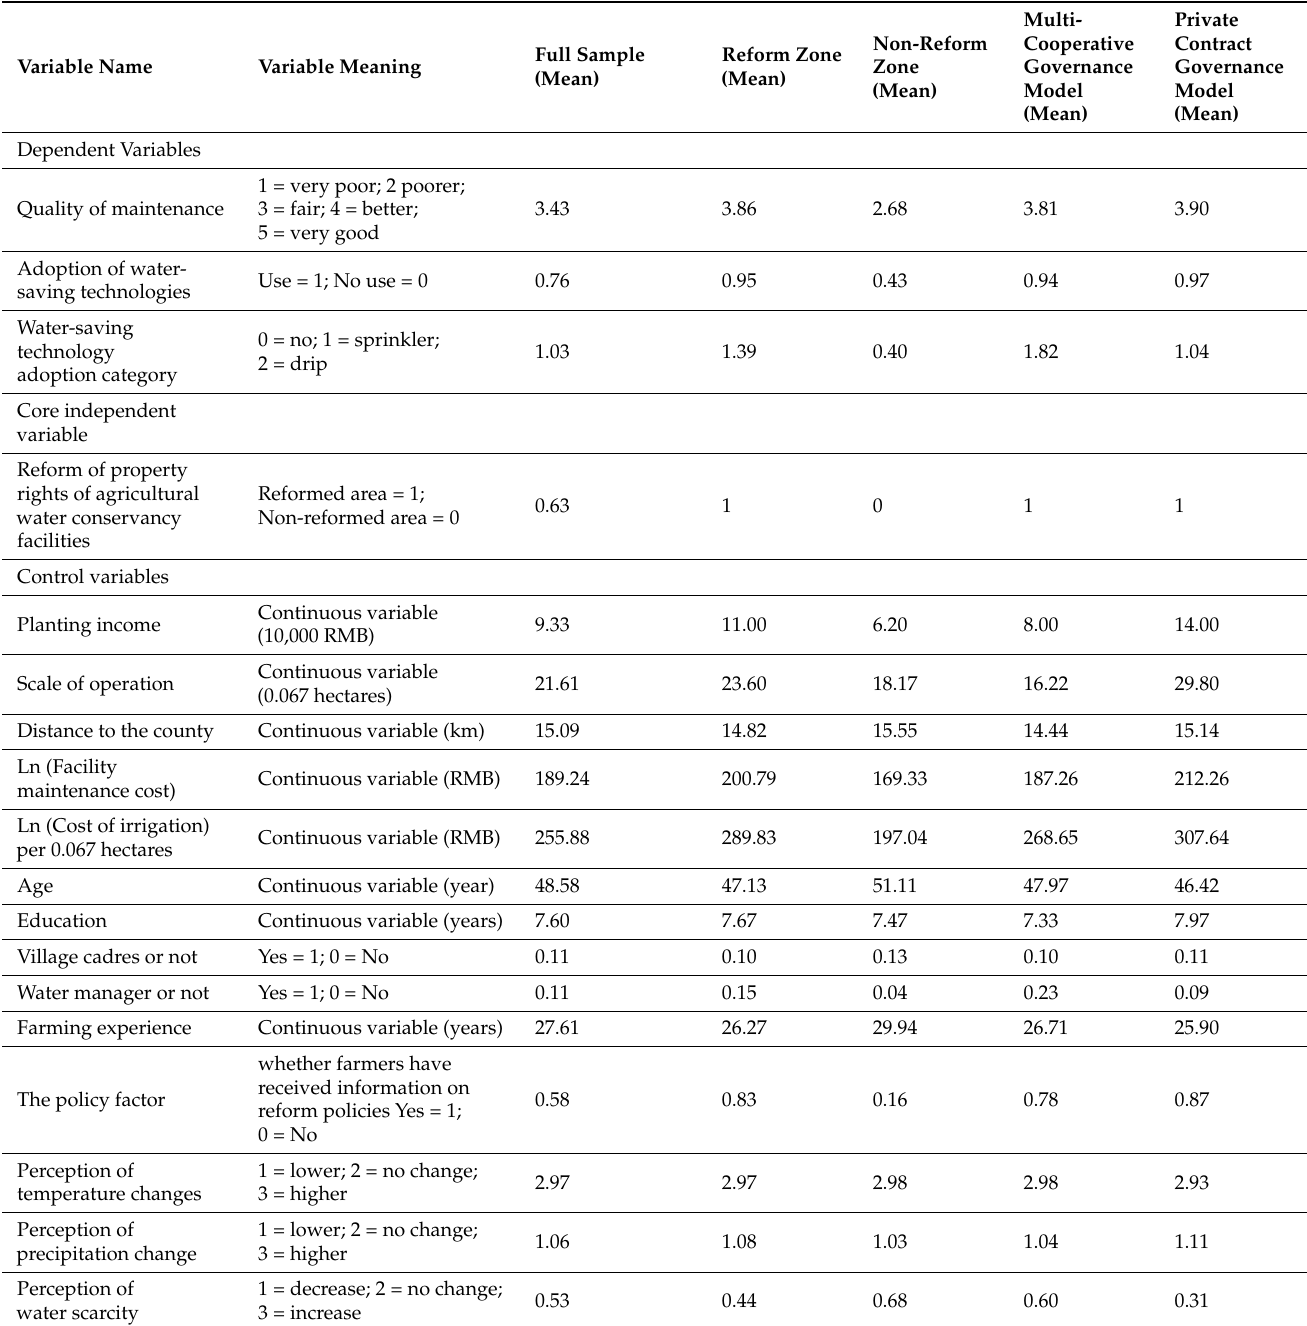
Table 2. Model variable settings and basic statistical